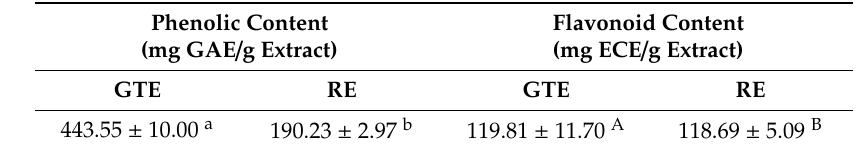
Table 2. Results of total phenolic compounds (expressed in mg Gallic Acid equivalents per g extract (mg GAE / g extract)) and total flavonoids results, (expressed in mg Epicatechin equivalents per g extract (mg ECE / g extract)), mean ± SD. Di ff erent letters are for significant di ff erences ( p <